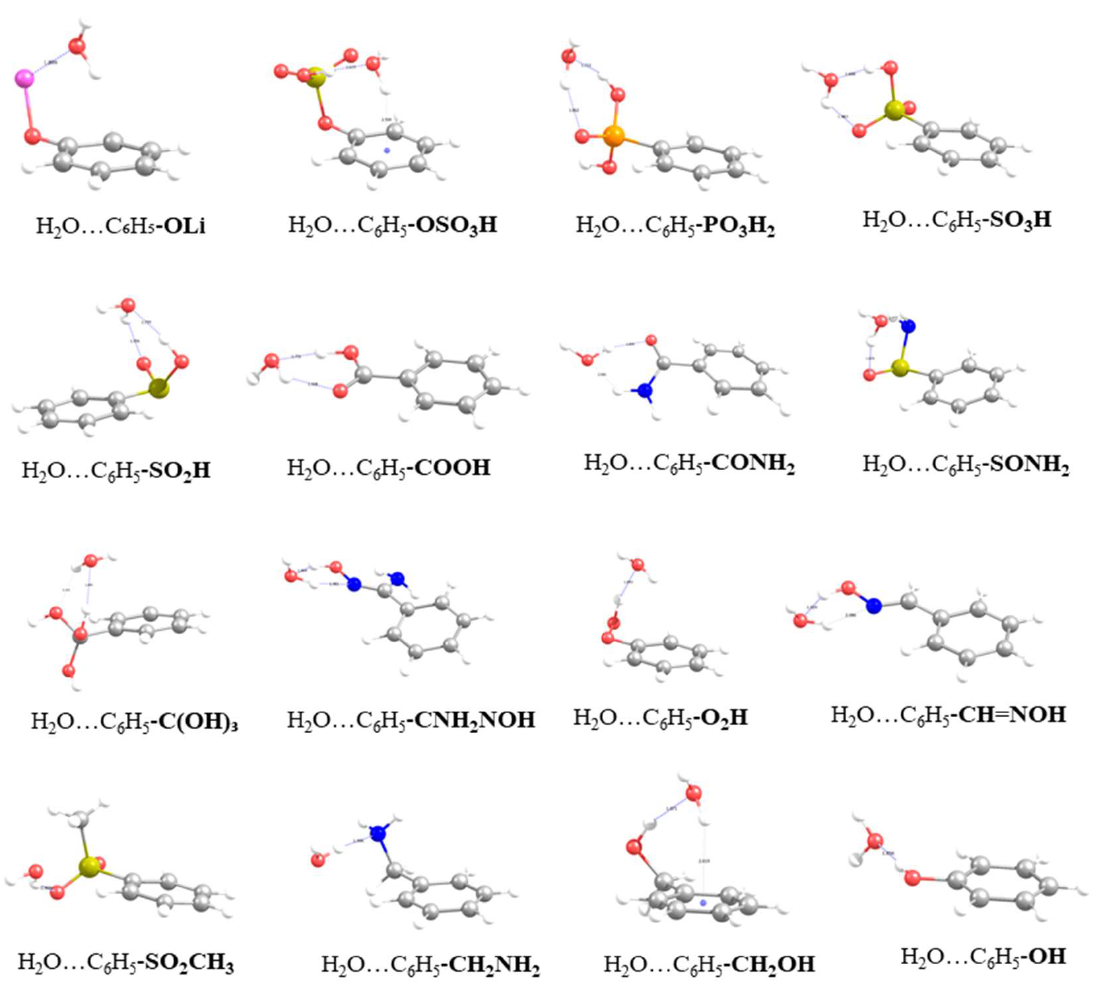
Figure 1. Optimized geometries at the RIMP2/def2-TZVPP-level of theory for the first subset of 16 functionalized benzenes.